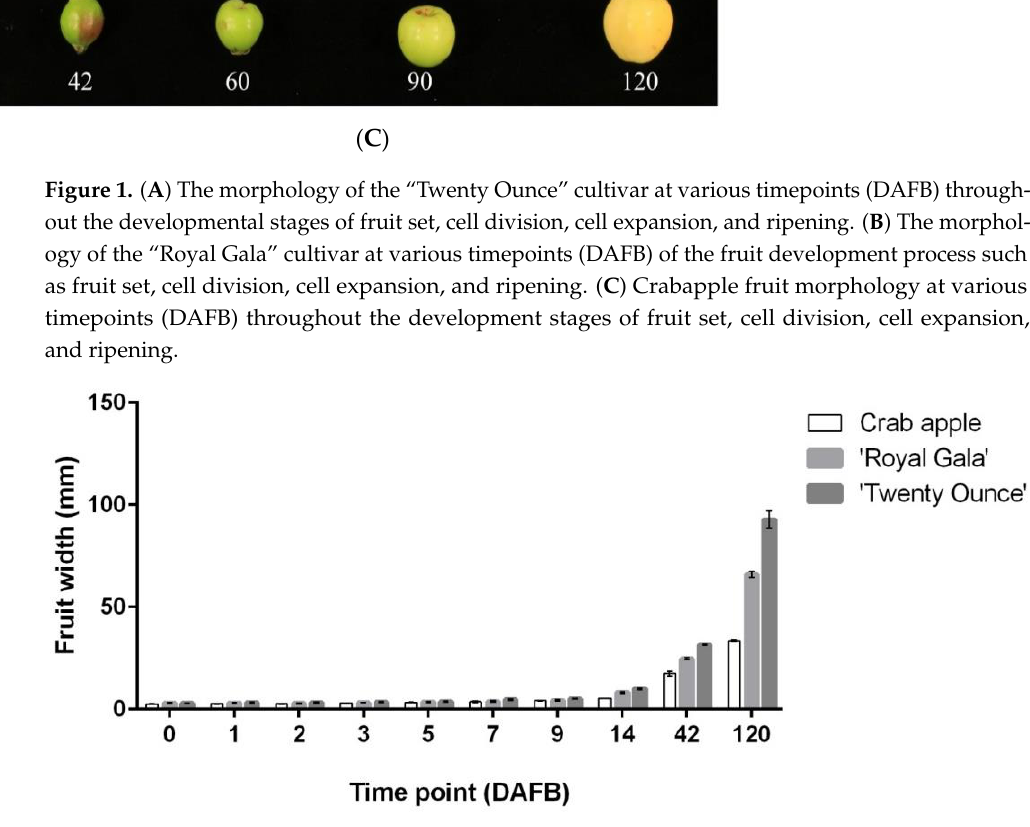
Figure 2. Average fruit diameter of the three cultivars from three individual replicates (Season 2). The differences in measurements between cultivars at 14, 42, and 120 DAFB were statistically different (Tukey’s HSD). ANOVA (two-factor), p -value ≤ 0.05. During the first experimental season, flowers and fruits were collected at 10 time points from 0 to 120 DAFB. Due to the need for more data from the early developmental stages, the number of collection time points was increased to 12 throughout the second experimental season. The cell coverage area of either the floral hypanthium or fruits was measured. Cell area measurements corroborated these findings as they were similar for all three cultivars along the same time points. Such outcomes were consistently obtained across the two seasons and further showed that cells in all cultivars expand at the same showed no significant differences in the cell sizes of the cultivars at either 0 or 120 DAFB (Figure